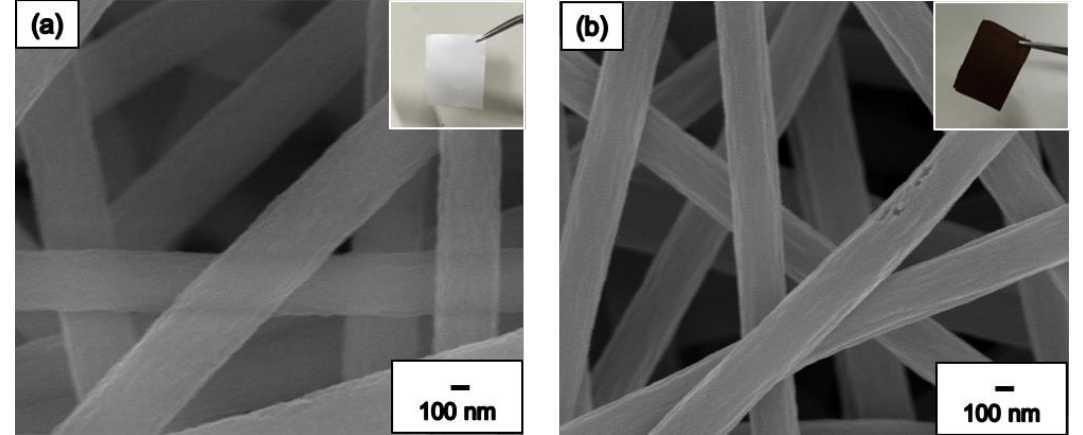
Figure 4. FE-SEM images of ( a ) pure PAN NF and ( b ) pure carbon NF with high magnification.